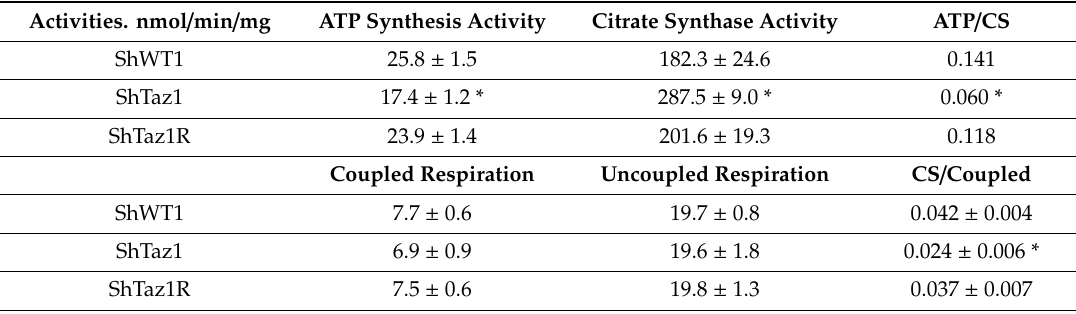
Table 2. Mitochondrial activities measured in intact permeabilized HeLa cell lines (ShWT1, ShTaz1, and